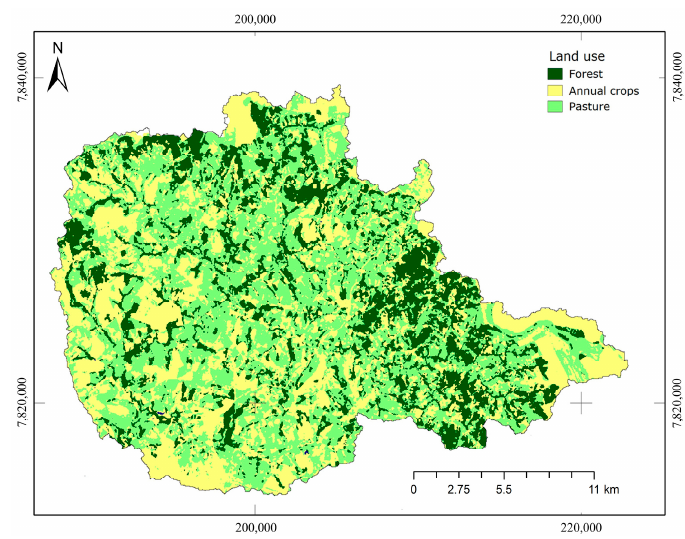
Figure 3. Land cover in the Environmental Protection Area of Uberaba River Basin. Adapted from Siqueira et al. [44].